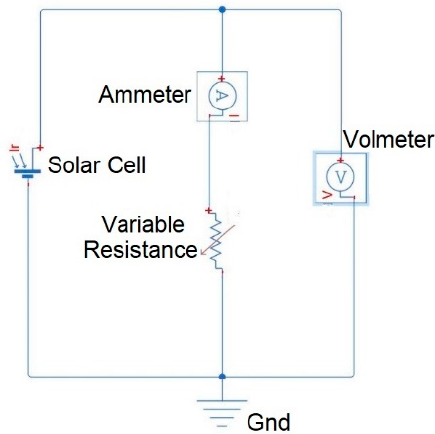
Figure 4. Scheme of the assemblies of the experiments.